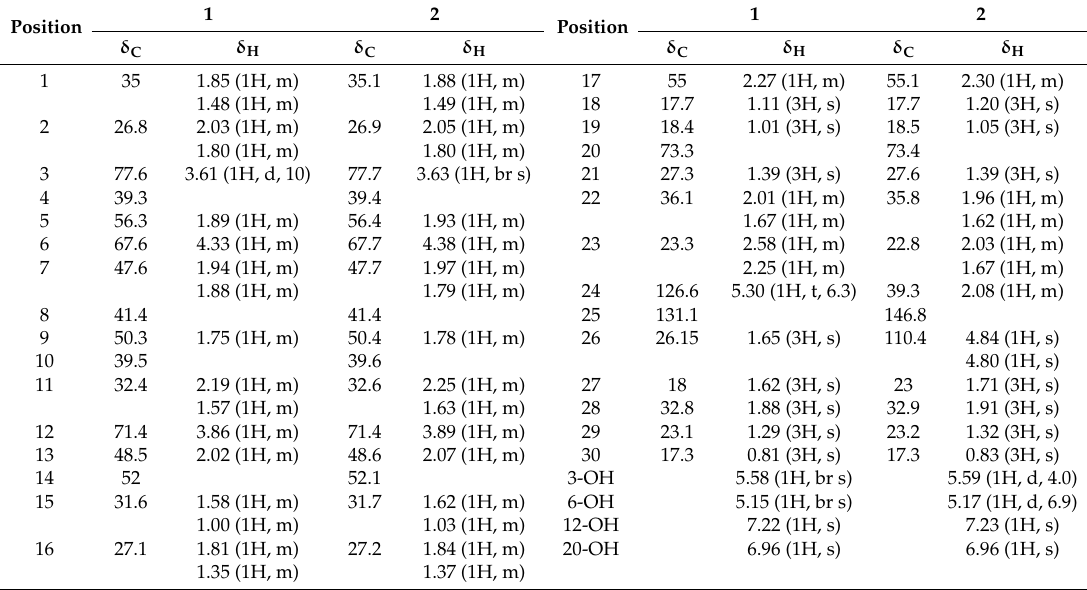
Figure 2. Chemical structures of 1 – 5 : ginsengenin-S1 ( 1 ); ginsengenin-S2 ( 2 ); ginsenoside-S3 ( 3 ); ginsenoside-S4 ( 4 ); ginsenoside-S5 ( 5 ). Table 1. 1 H and 13 C-NMR (600 MHz, 150 MHz in C 5 D 5 N) data for 1 and 2.